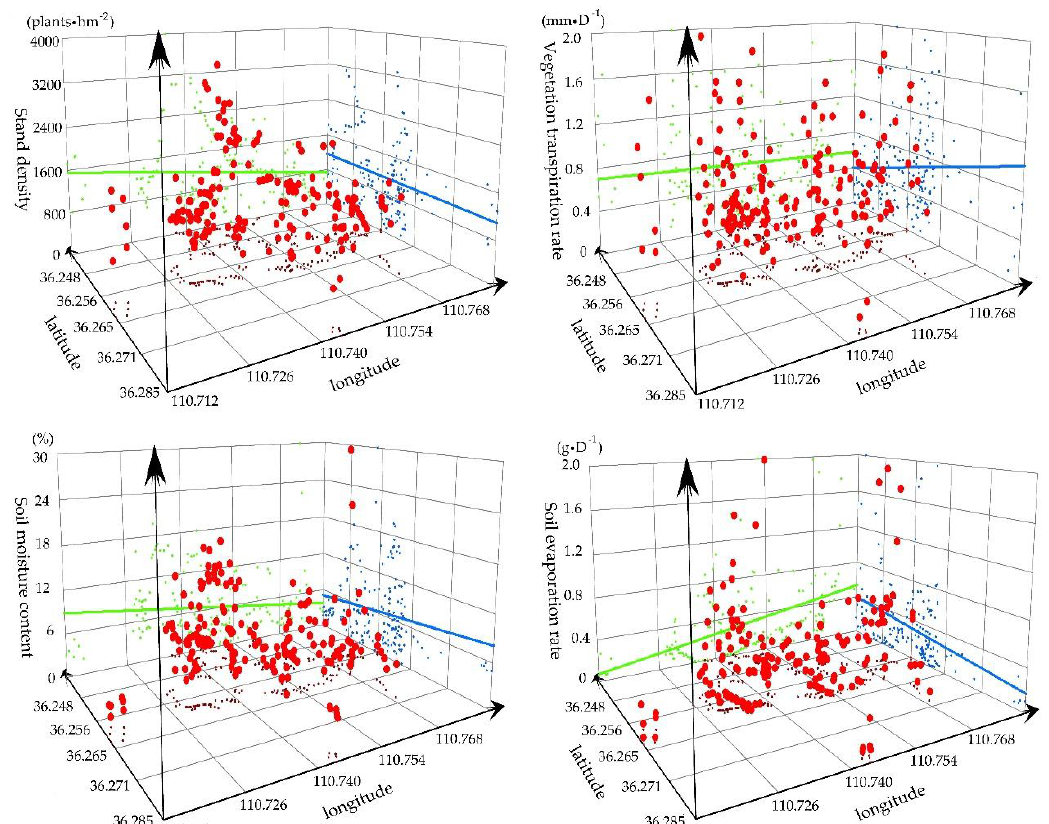
Figure 2. Spatial distribution of stand density (SD), vegetation transpiration rate (VTR), soil moisture content (SMC) and soil evaporation rate (SER).